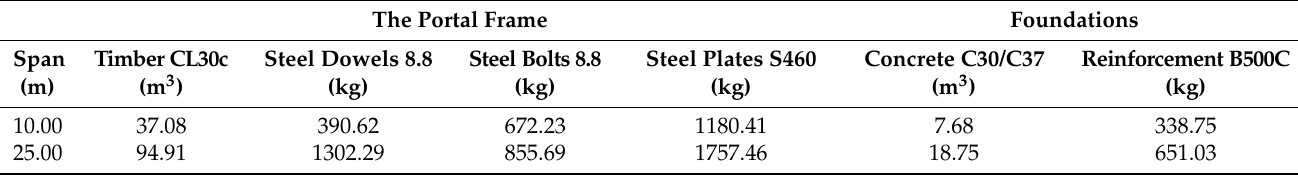
Table 2. Quantities of the timber